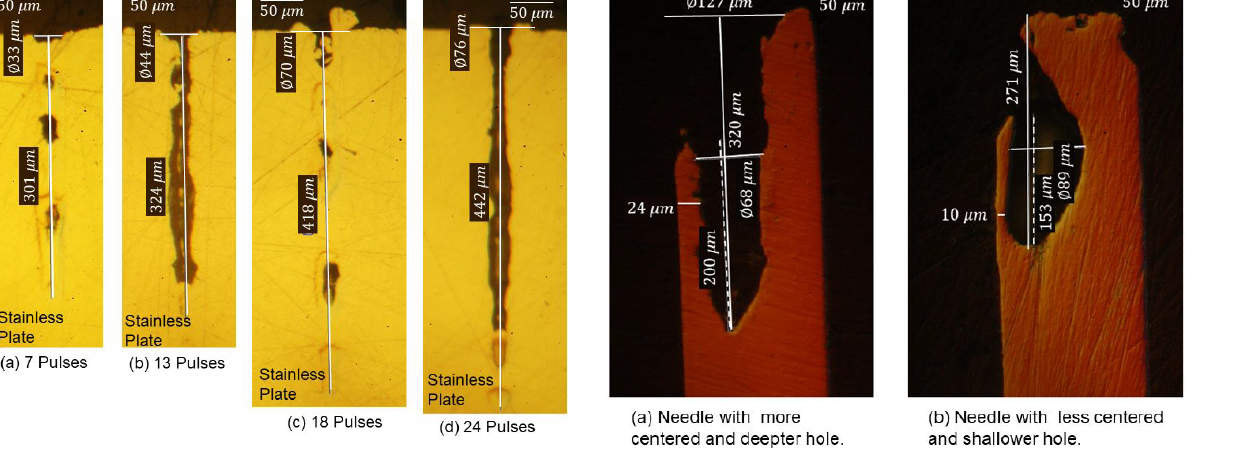
Figure 12: Microneedles drilled by 7 repetitions of the three 13 µ s pulse group.